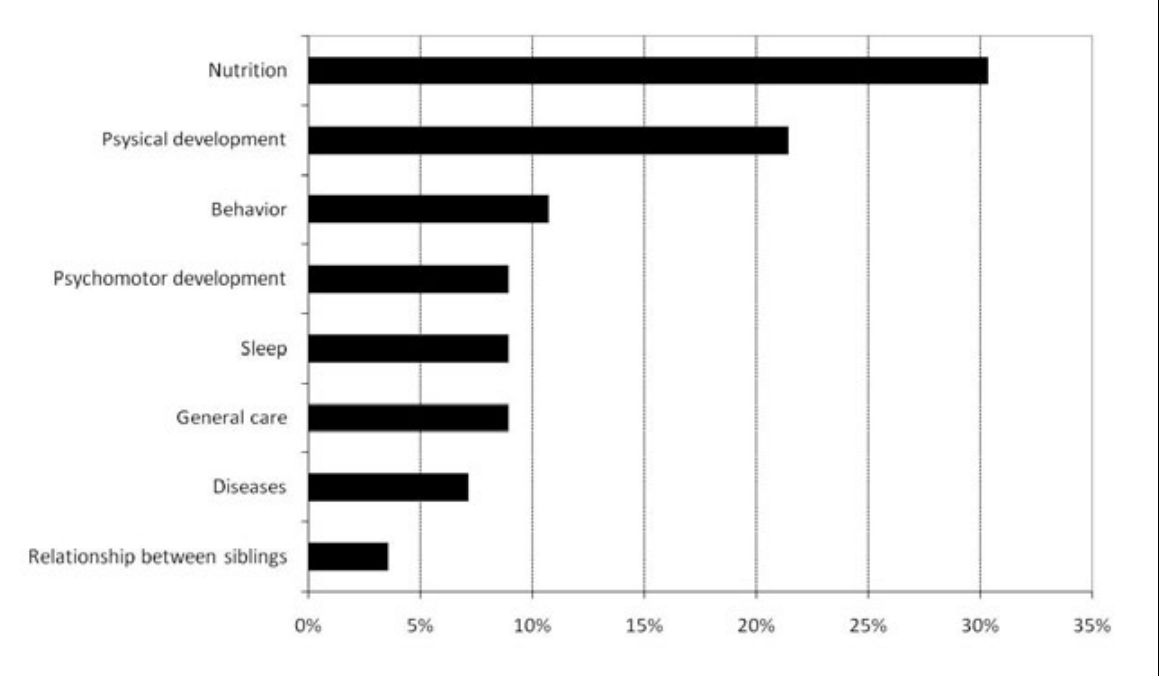
Figure 4. Doubts and concerns of mothers according to pediatricians.